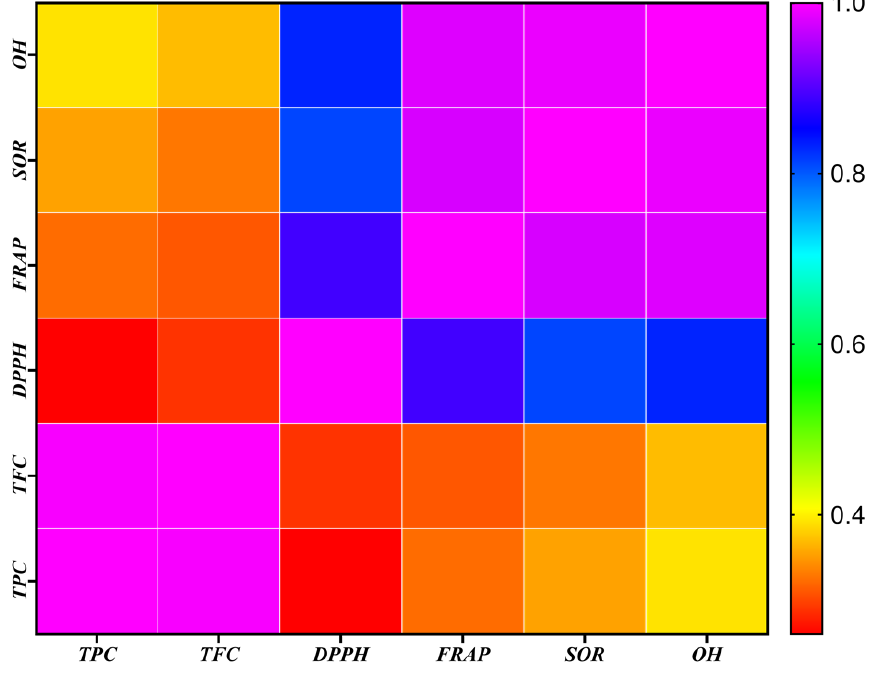
Figure 4. Pearson correlation coefficients for total phenolic content (TPC), total flavonoid content (TFC), and antioxidant activities 1-diphenyl 1-2-picryl-hydrazyl (DPPH), ferric-reducing antioxidant power (FRAP), superoxide radical scavenging (SOR) and hydroxyl radical scavenging (OH − ) activity of A. chasmanthum extracts.